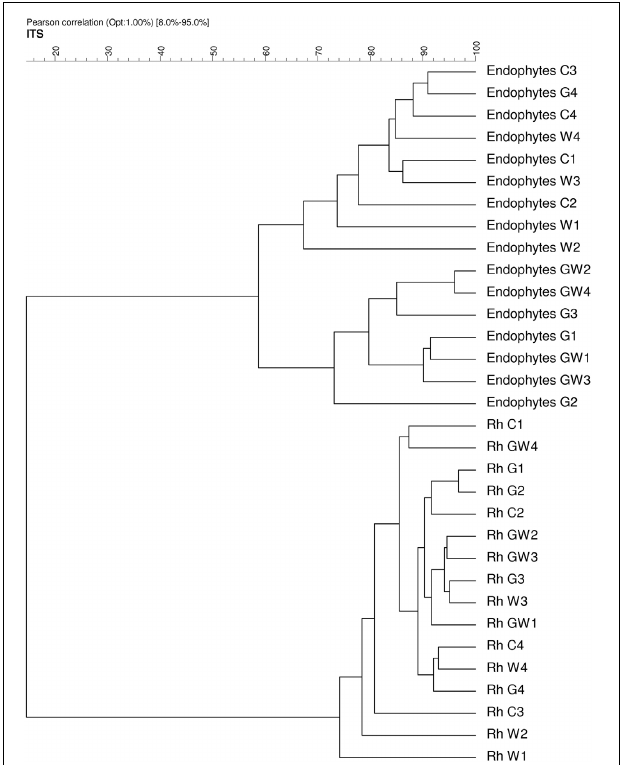
FIGURE 3 | Dendrogram constructed with the fungal communities fingerprints in the endorhiza and rhizosphere of maize reported in Figure 2. The differences between the profiles are indicated by percentage of similarity. The dendrogram was based on the Pearson correlation indices and cluster analysis by the unweighted pair group method using arithmetic